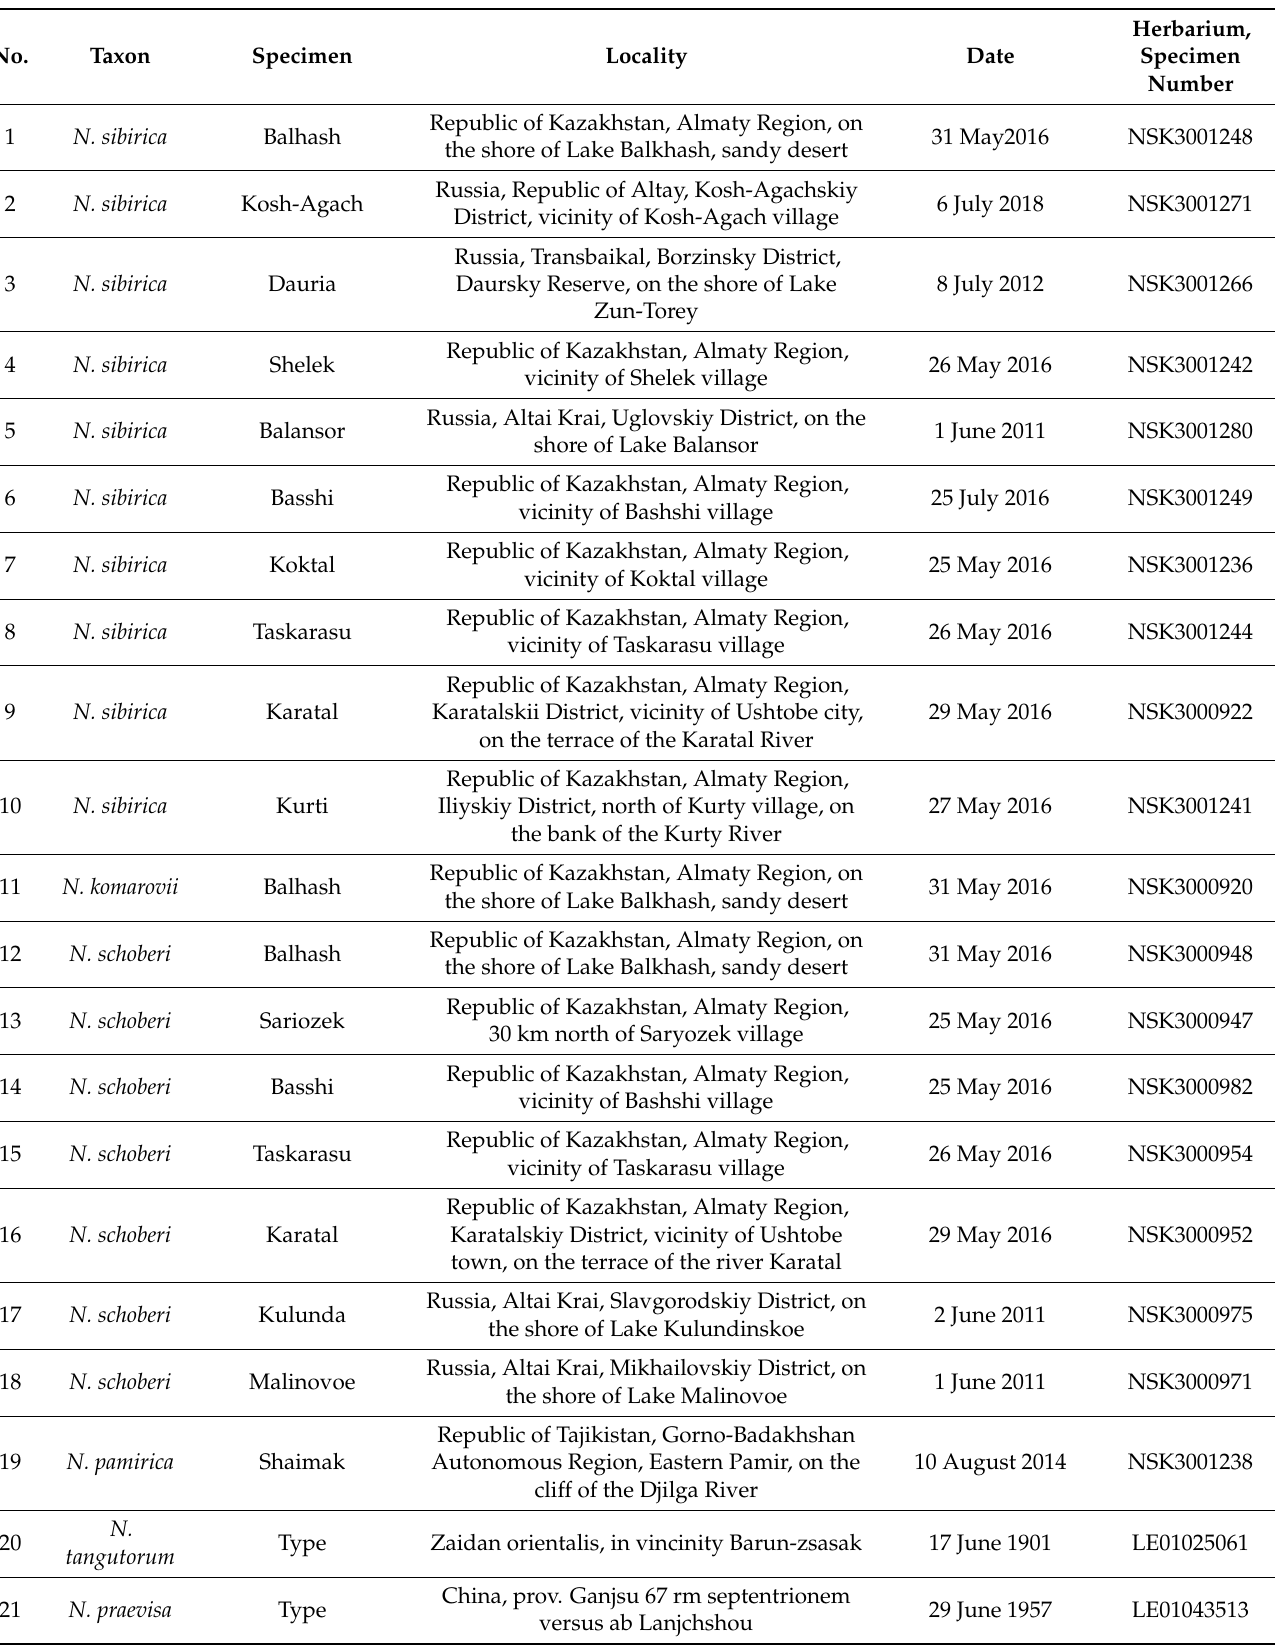
Table 2. Vaucher specimens of Nitraria